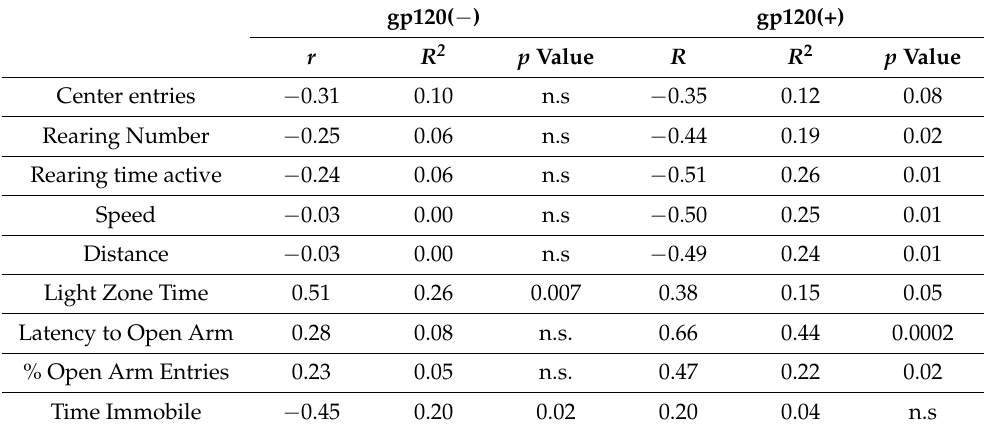
Table 2. Significant correlations between age (in days) and behavioral